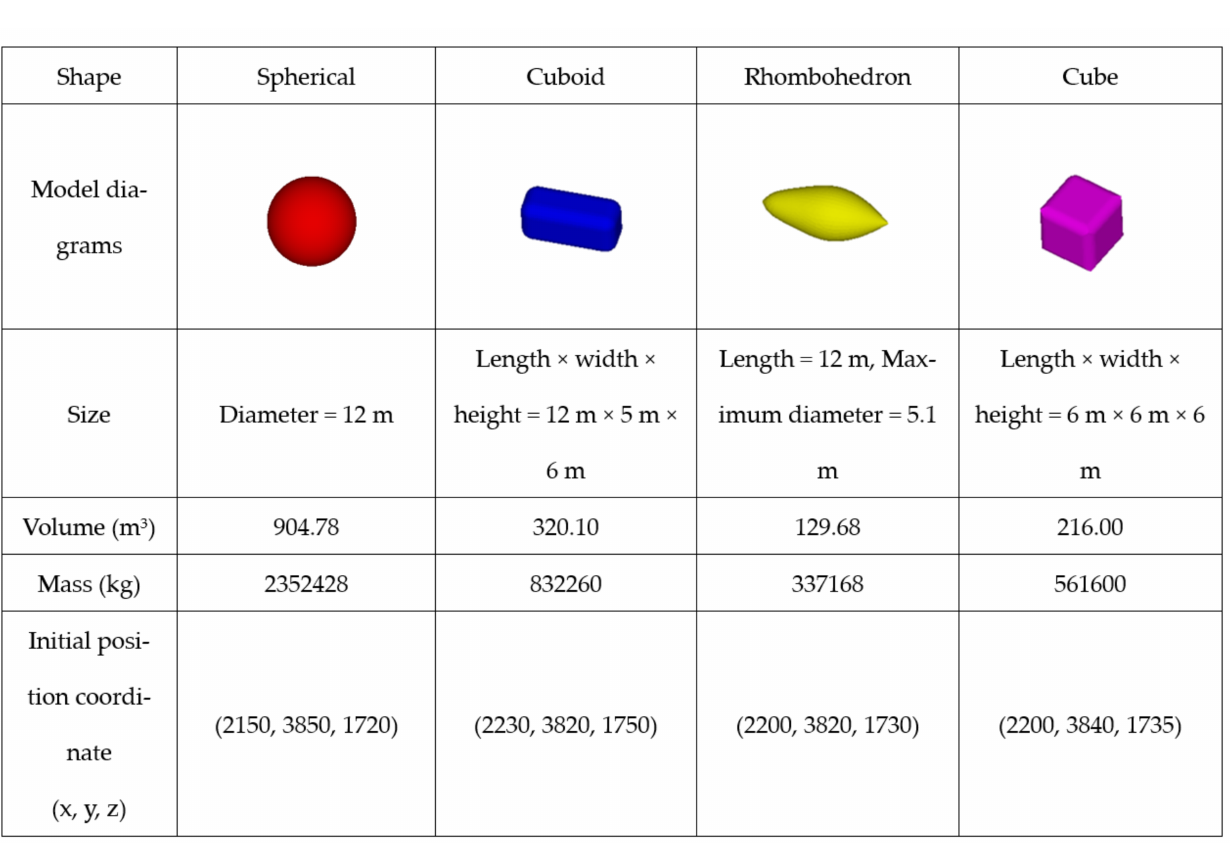
Figure 3. Parameters of boulders (the origin of x and y coordinates is the left and lower side of the DEM model, and z is the elevation).